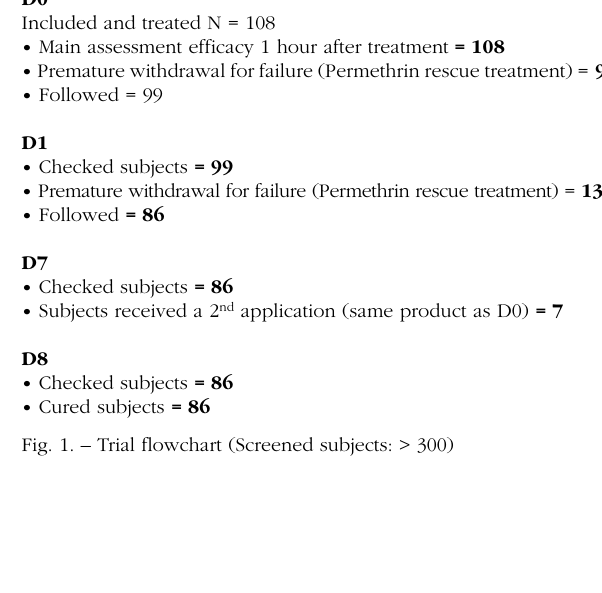
Fig. 1. – trial flowchart (Screened subjects: > 300)